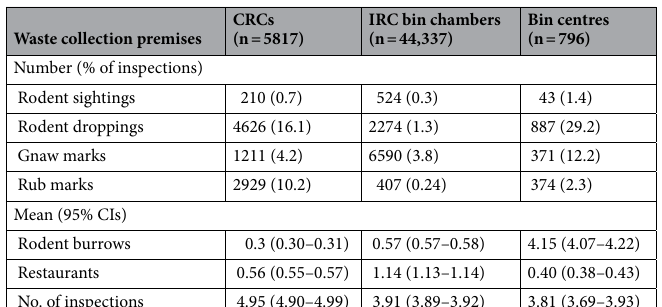
Waste collection